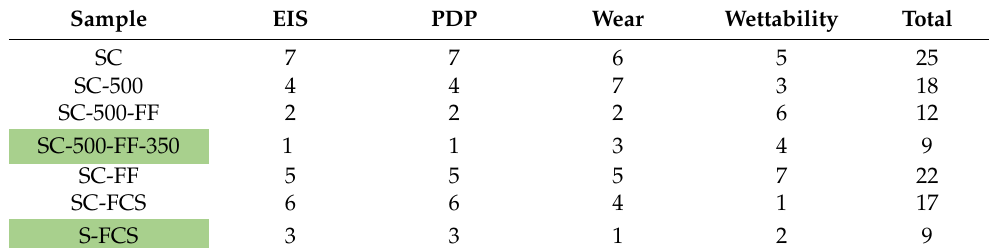
Table 7. Results of various coating tests (where 1—the best, 7—the worst; the smaller the number, the better protective properties). Estimated parameter for columns: EIS—the impedance modulus at a frequency of 0.1 Hz, PDP—the corrosion current density, wear—the number of cycles to the coating wear, wettability—the contact angle, total—summarized score (the smaller the score, the better protective properties). The samples with the best protective coatings are marked with green color.